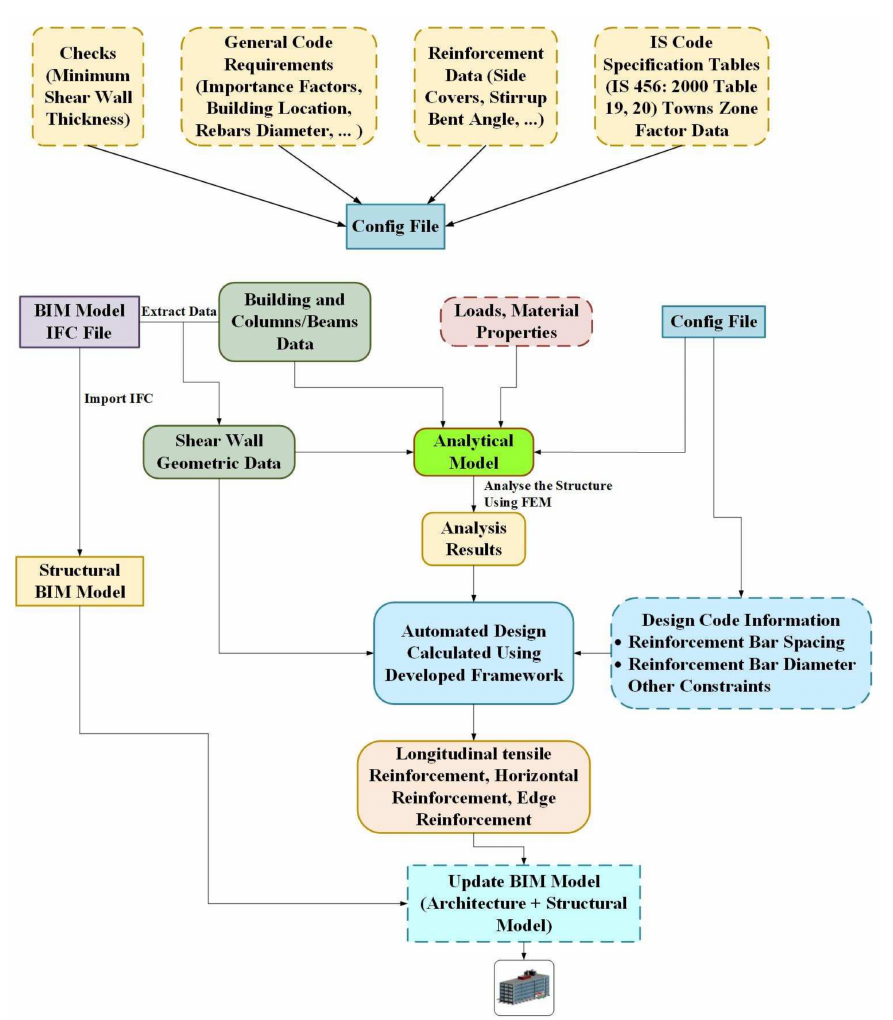
Figure 2. Architectural diagram for the automated system